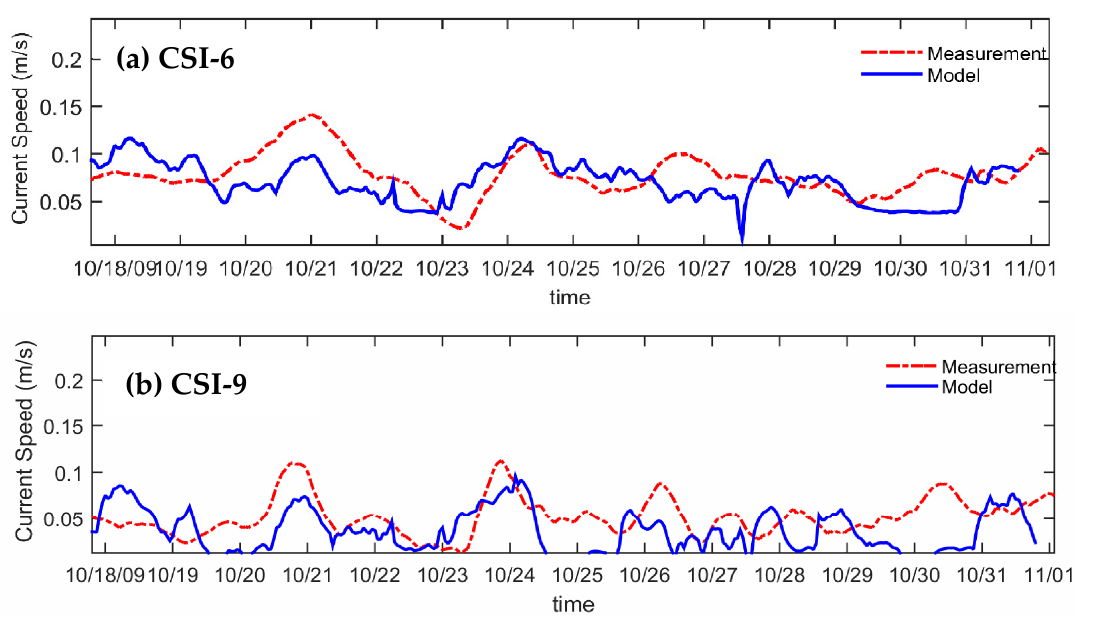
Figure 6. Comparison of simulated current speed and measured de-tided current speed at ( a ) CSI-6 and, ( b ) CSI-9.